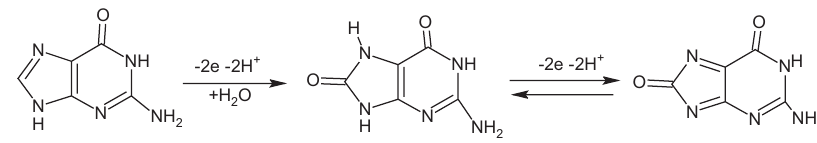
Figure 4 The electro-oxidation reaction mechanism of the GU mechanism of GU in solution. plotted with the equation: iP ( µ A) = 1.069 V (mV/s ) +